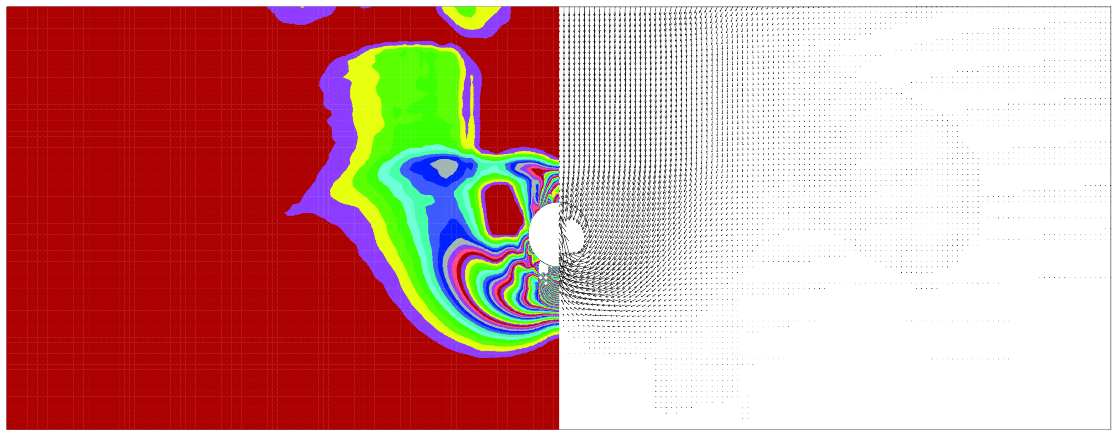
Figure 12. Shear strain rate (SSR) and velocity plot for C/D = 3, γD/S u = 5 .